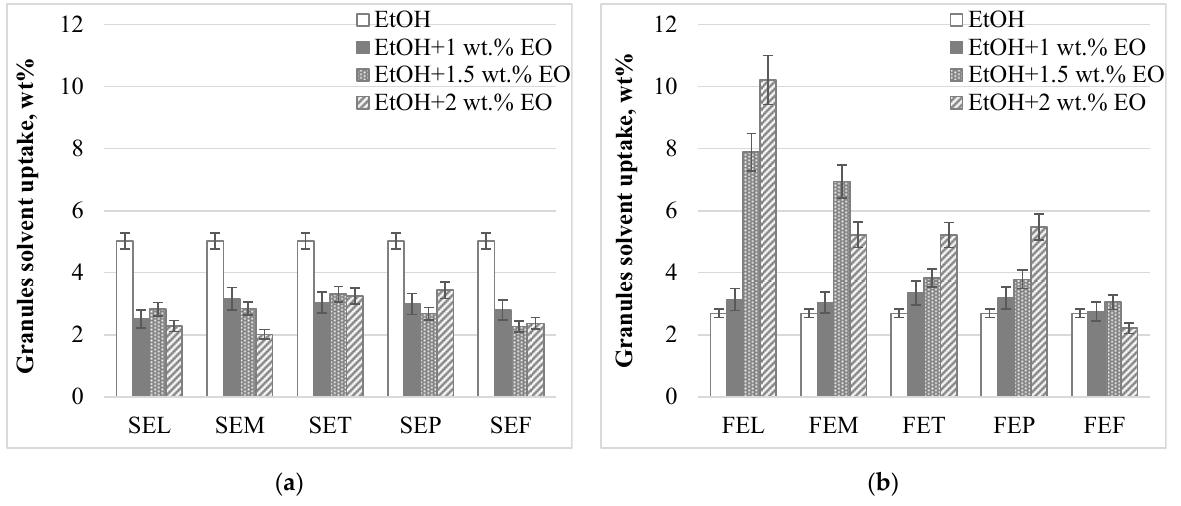
Figure 1. Solvent uptake in ethanol at different concentration of essential oil: ( a ) 4043D granules; ( b ) 3D850 granules.